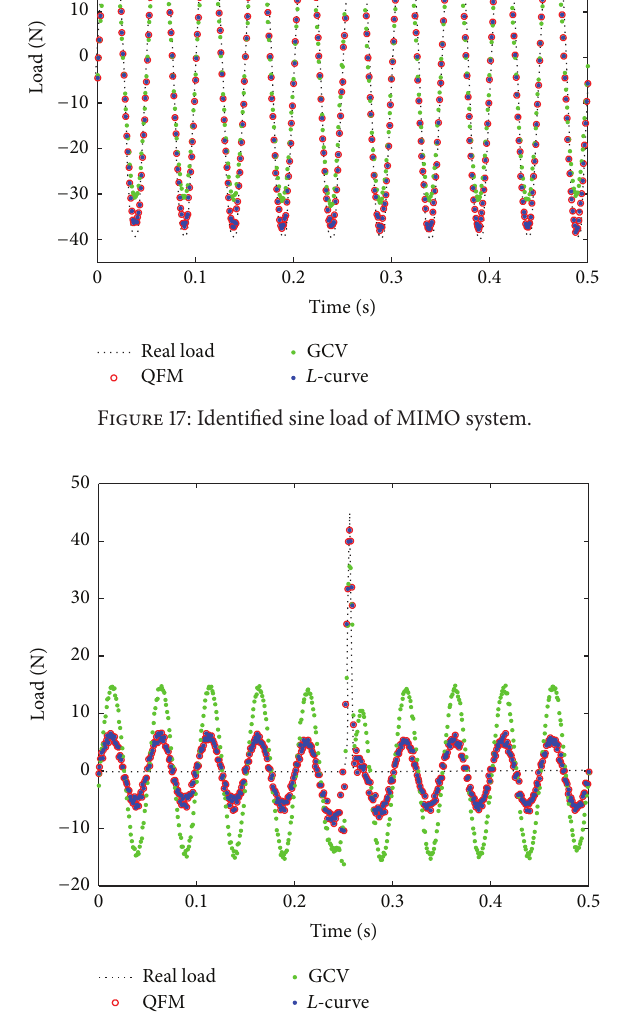
Figure 18: Identified impact load of MIMO system. Table 5: Relative results of laboratory experiment of SISO system. Method